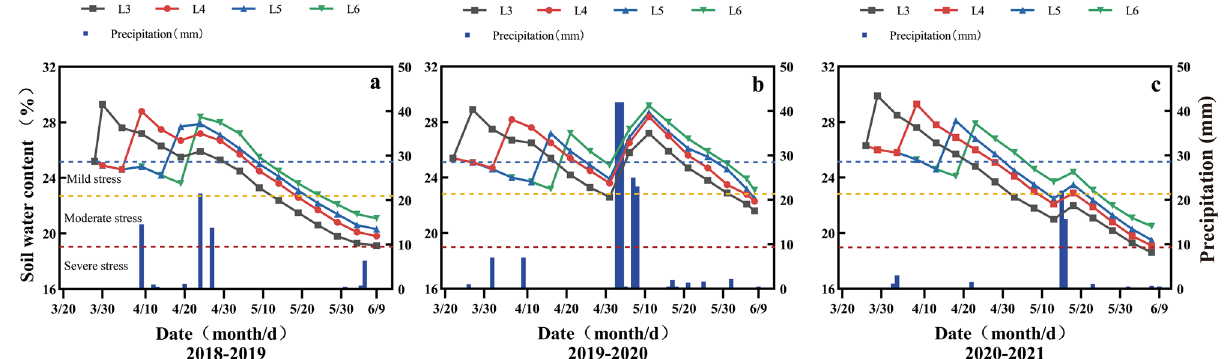
Figure 6. Average water content of the 0–60 cm layer of farmland soil under different treatments in 2018–2019 ( a ), 2019–2020 ( b ) and 2020–2021 ( c ) and precipitation and irrigation in the test area. According to the Mild stress (soil relative water content 65–70%); Moderateild stress (soil relative water content 55–65%); Severe stress (soil relative water content < 55%).